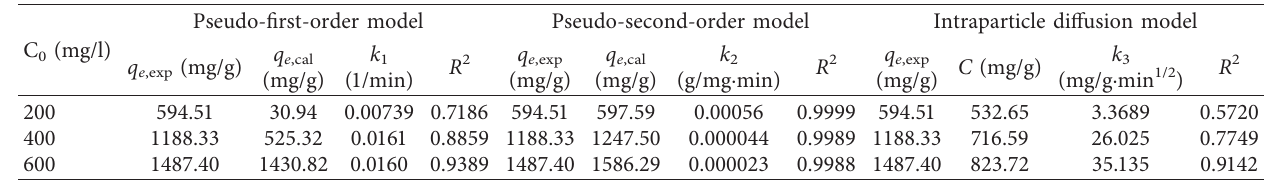
Table 6: Adsorption kinetics